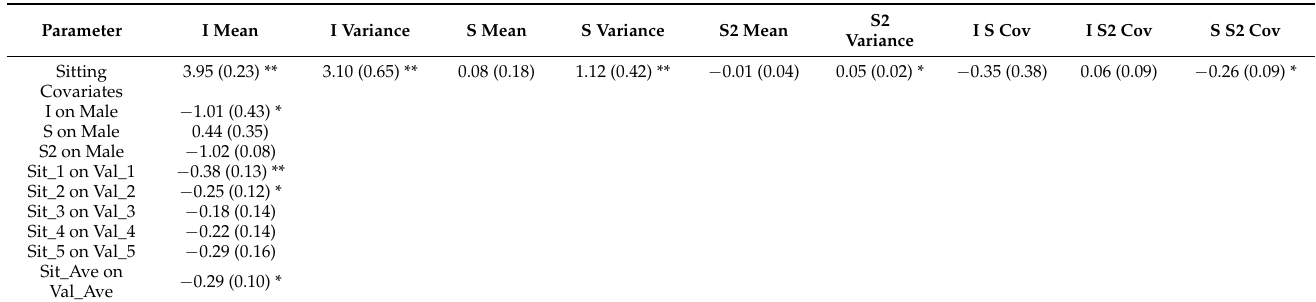
Table 4. Parameter estimates from latent growth model